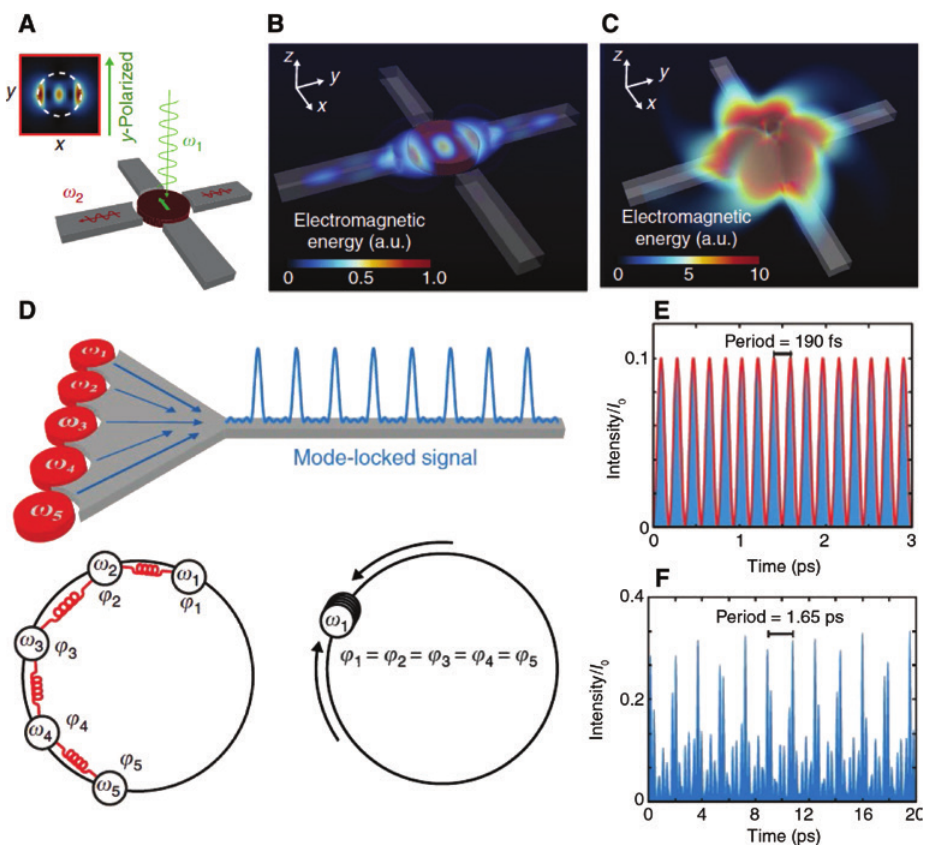
Figure 7: Concept of an anapole